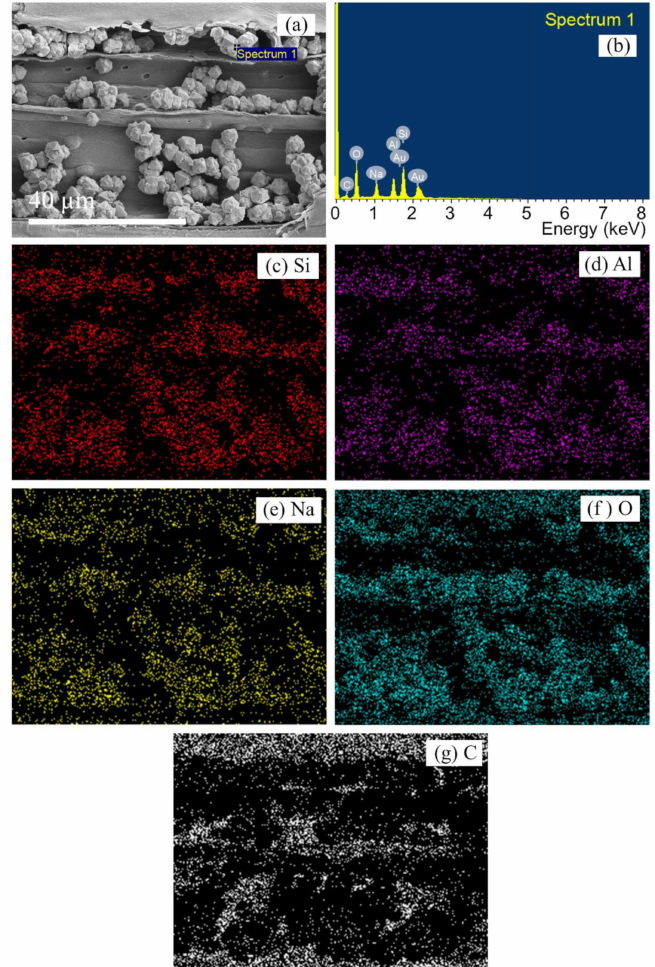
Figure 7. SEM-EDS elemental mapping of refluxed wood-zeolite composite with sonication (RS) ( a ) SEM image, ( b ) EDS spectrum, distribution of ( c – g